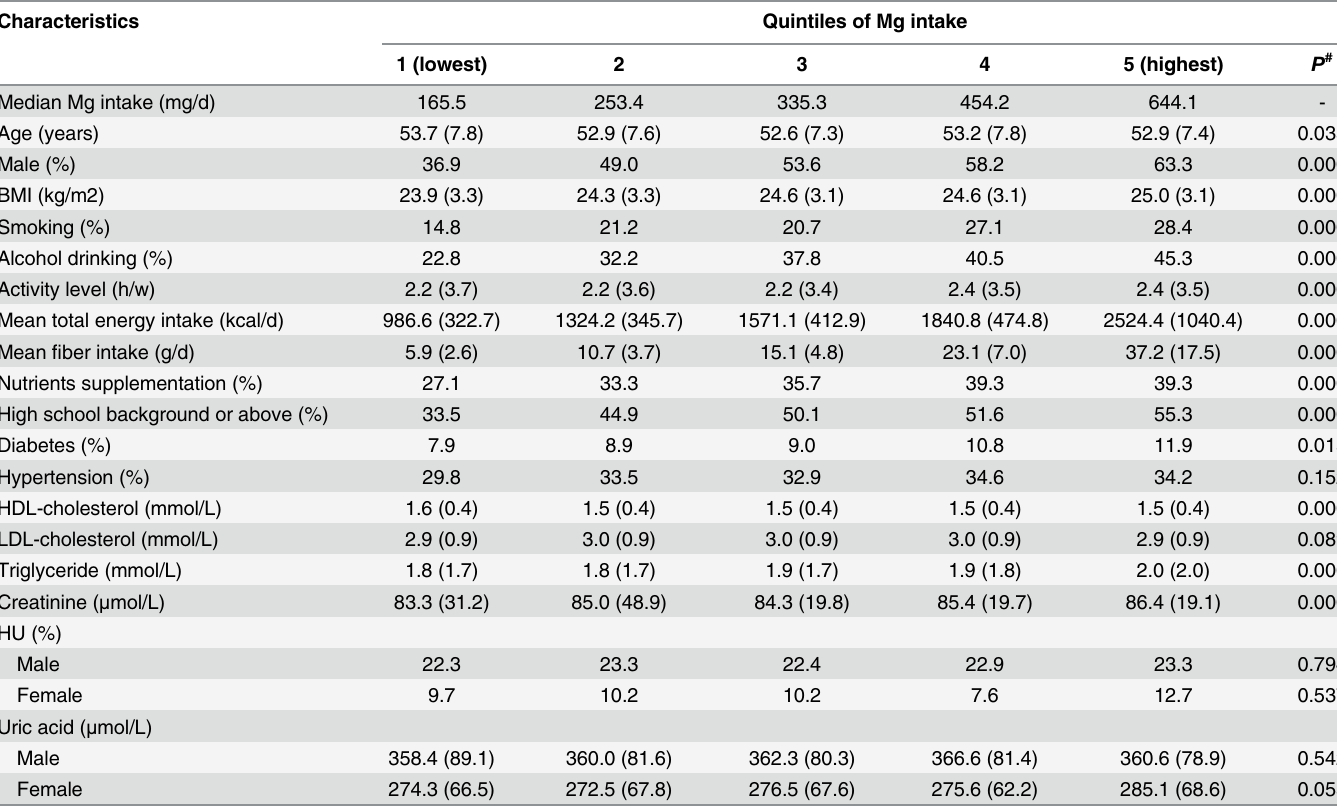
Table 2. Characteristics among 5168 participants according to quintiles of total Mg intake. Data are mean (Standard Deviation), unless otherwise indi- cated; Mg,